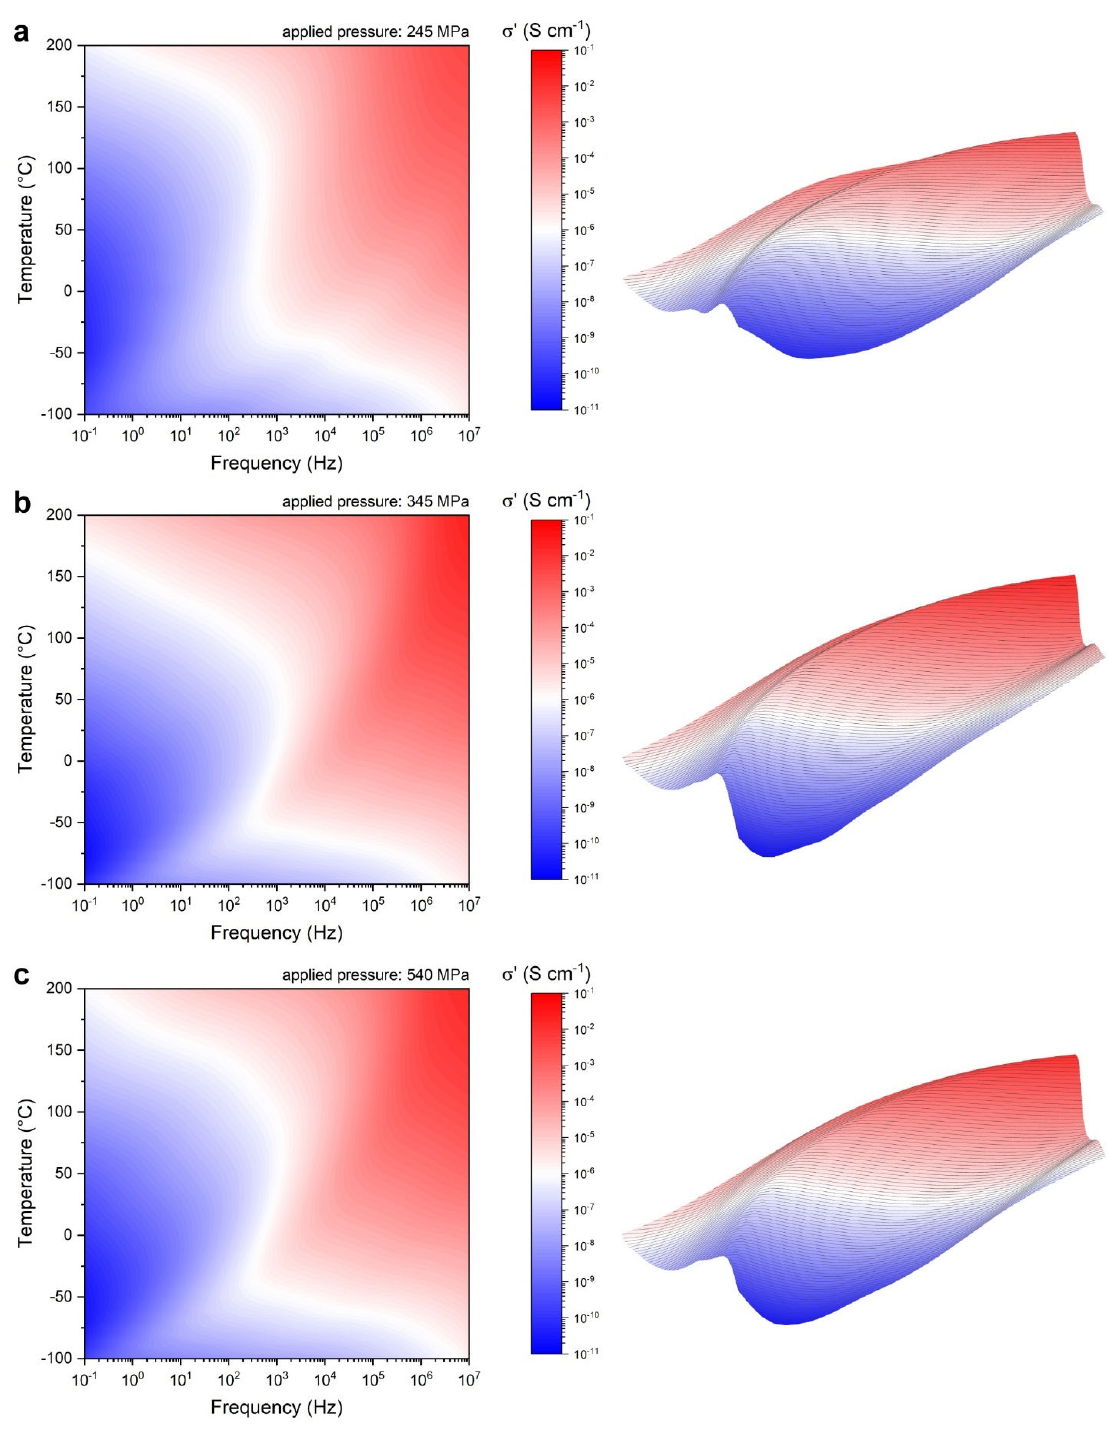
Figure 8. Parametric 2D and 3D phase ‐ space mappings of the real component σ ’ of conductivity scanned over a broadband frequency range of 10 − 1 to 10 11 Hz and for temperatures ranging from 200 °C to − 100 °C. Scans for NASICON pellets assembled by applying pressure levels of ( a ) 245 MPa, ( b ) 345 MPa, and ( c ) 540 MPa are displayed. 3D mappings portray the XY plane reflected across the Y -axis bisector, revealing the frequency-dependent dispersion region as a narrow diagonal ridge preceded by the dc plateau. Conductivity scales adhere to the common colormap to the right of the figures. In Figure 9, the results of the fitting procedure are displayed. Bulk dc conductivity, σ dc , clearly displays temperature dependence by rising proportionally with temperature for